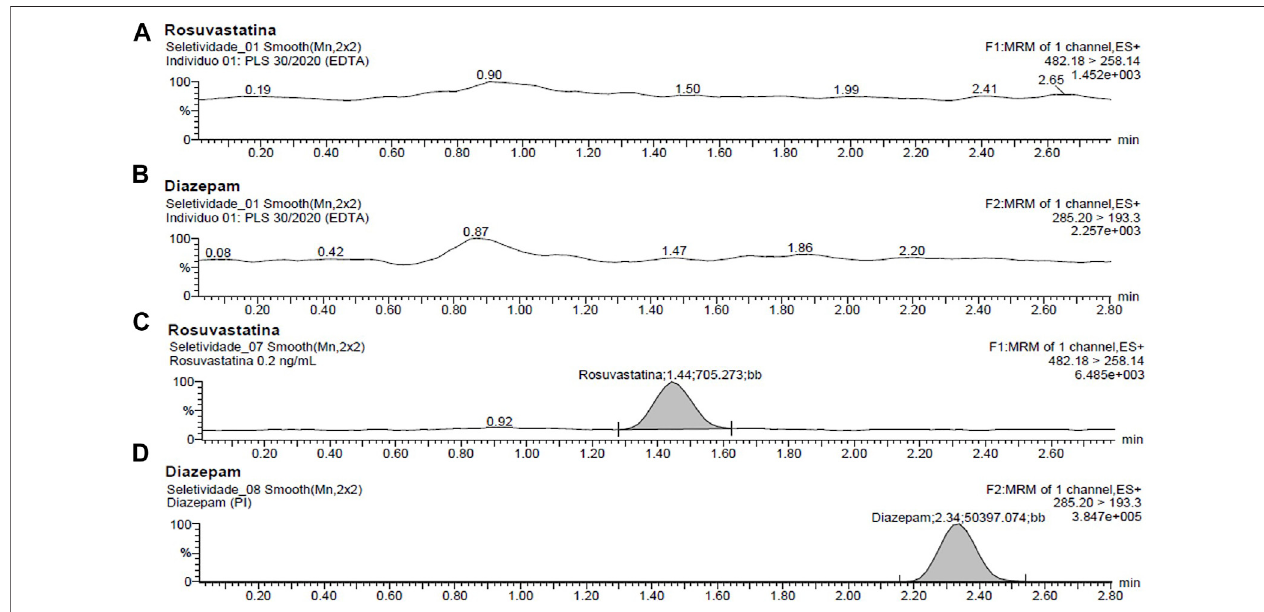
FIGURE1 | Representative multiple reactionmonitoring(MRM) chromatogramsof rosuvastatin in humanplasma: (A) rosuvastatin and (B) diazepamblank human plasma; (C) rosuvastatin and (D) diazepam-spiked human plasma containing 0.2 ng ml − 1 rosuvastatin and internal standard.